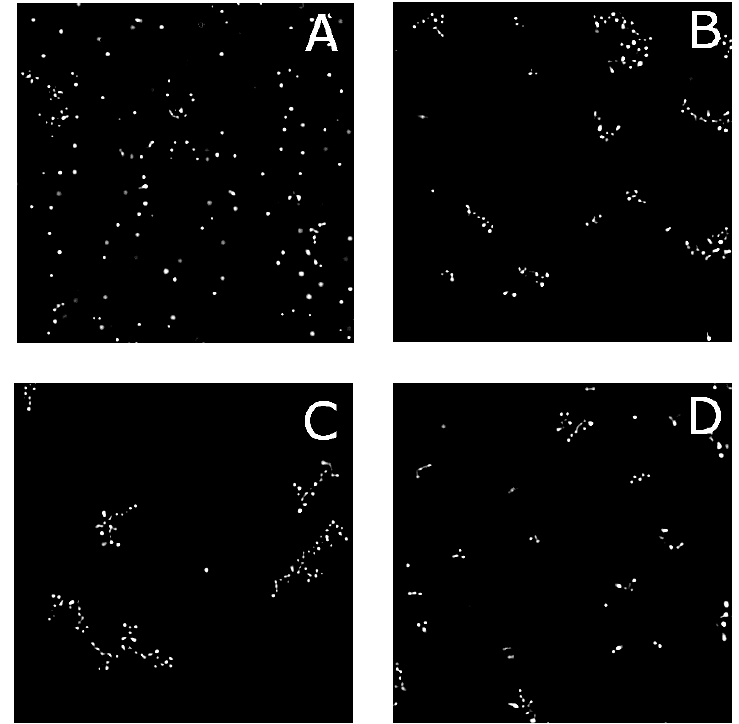
Figure 3. Optical microscopy images for different grafting densities at 32 ◦ C in 30 mM NaCl for DP = 100.